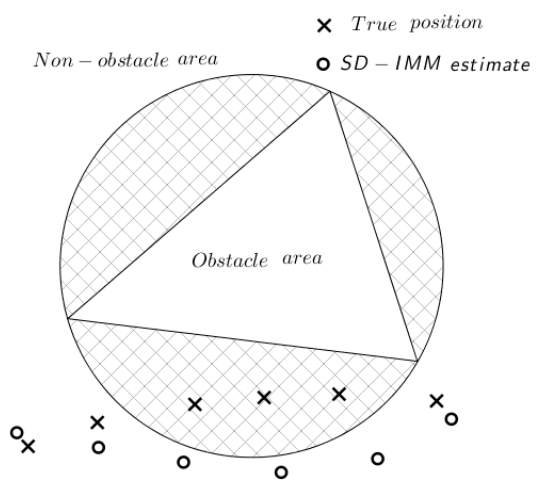
Figure 1. State-dependent variations of the interacting multiple-model ( SD-IMM) algorithm scenario, with estimates at the obstacle area (three error estimates).